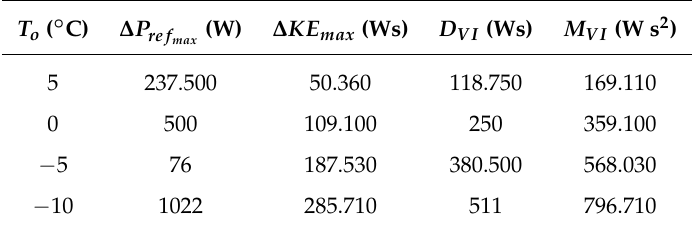
Table 5. The determined virtual inertia control parameters for different outdoor